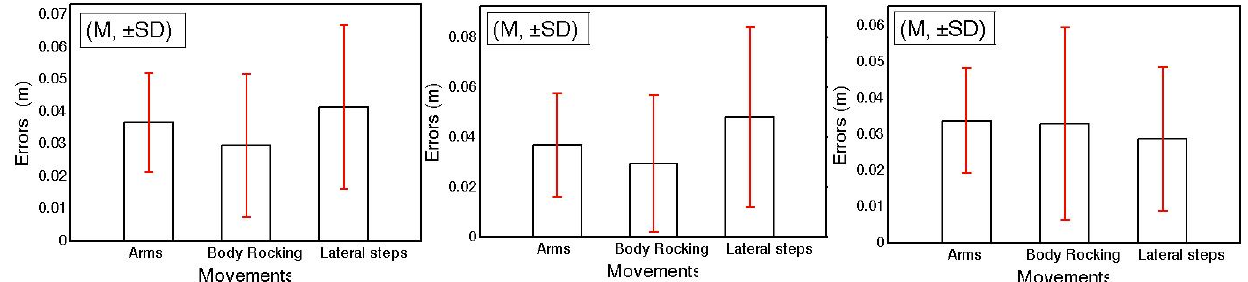
Figure 18. For all tested movements: CoP error on X between the trajectories provided by Arboris replaying Kinect data and CodaMotion (left); between the posturography platform measurements and the Arboris results with Kinect data as input (center); between the posturography platform measurements and the Arboris results with CodaMotion data as input (right).